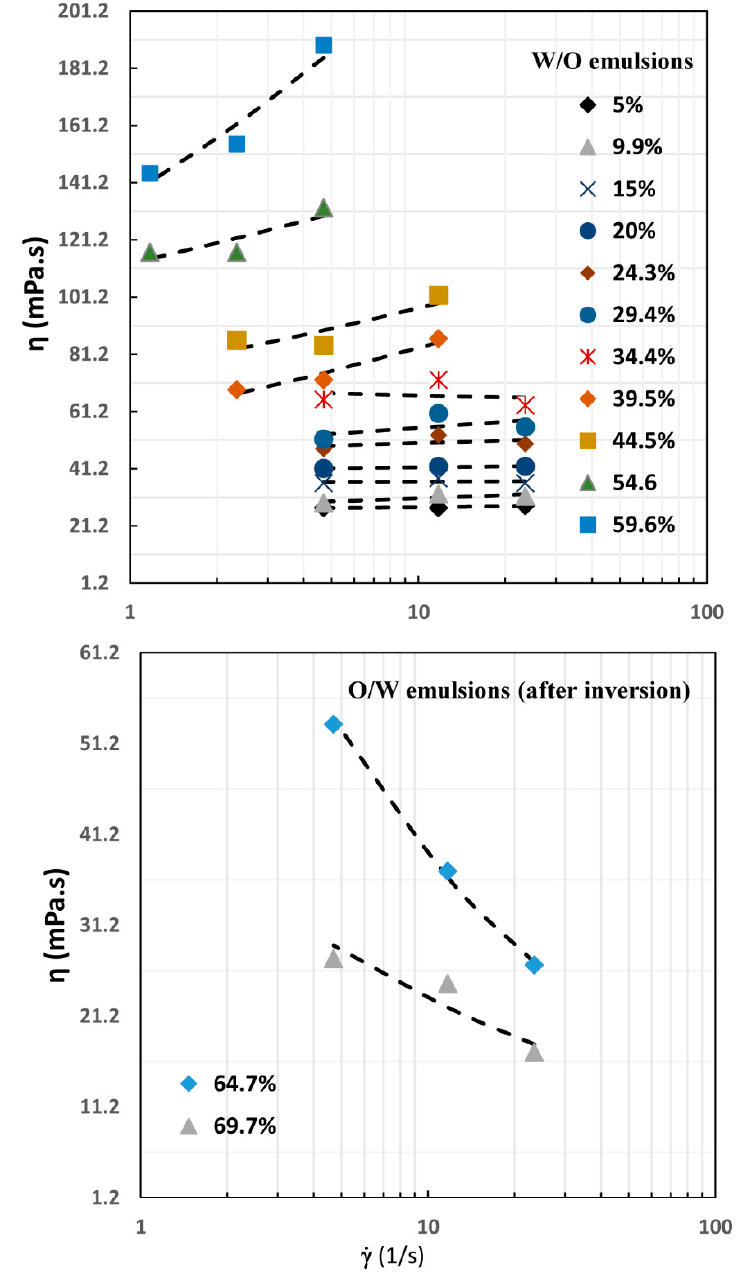
Figure 7. Flow behavior of emulsions with SNP concentration of 2.0% wt. in the aqueous phase. The dashed lines are shown as a guide to the eye. The percent concentrations indicated on the figure are volume percent of aqueous